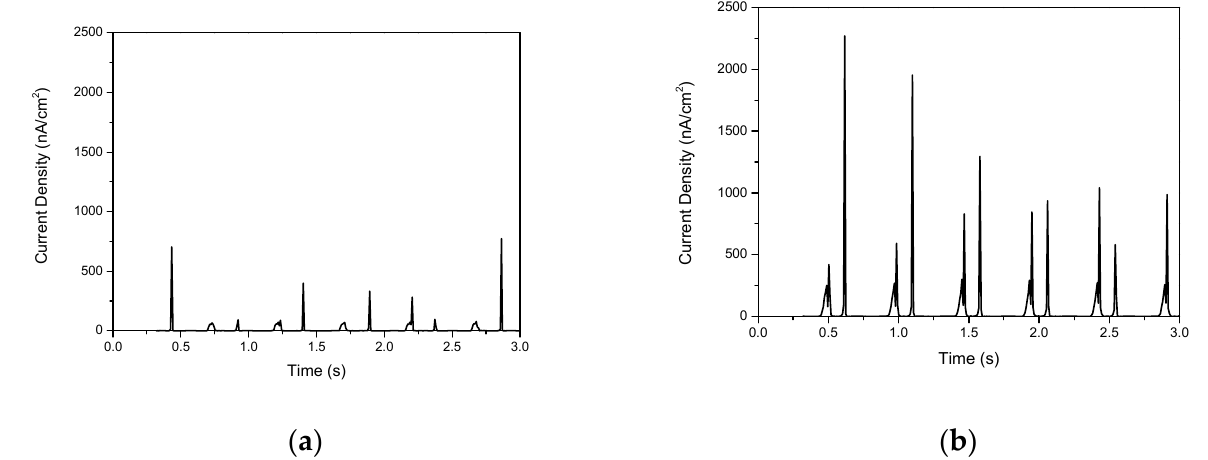
Figure 10 . Current density of piezoelectric NGs based on ZNRs and an 80- μ m-thick PDMS layer: ( a ) aspect ratio of 11:1 without PEI, ( b ) aspect ratio of 24:1 with PEI in precursor solution.